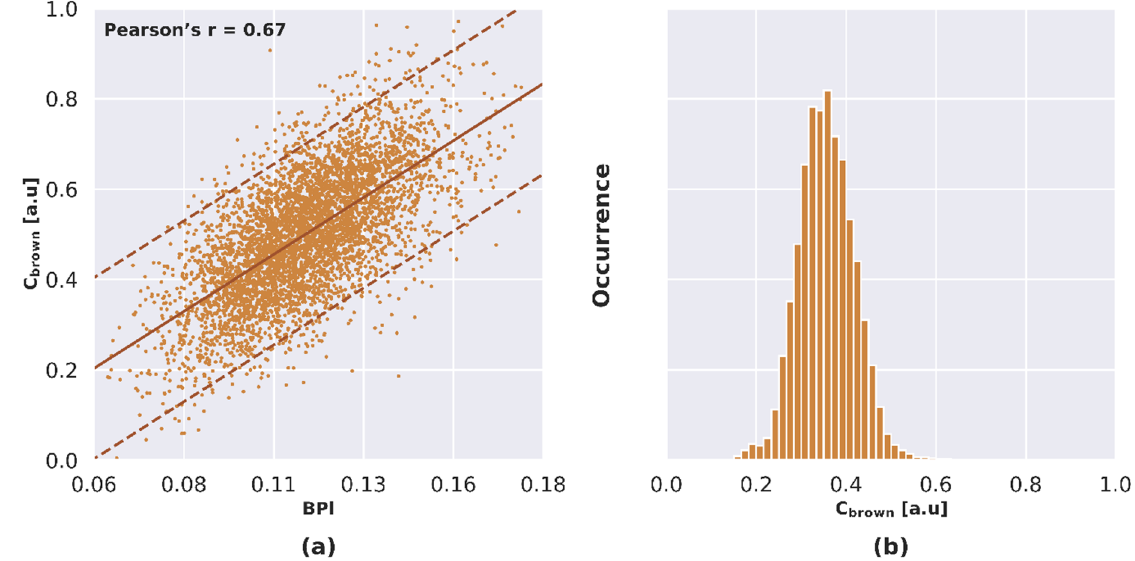
Figure 5. ( a ) Relationship between Brown Pigment Reflectance Index (BPI) and C brown obtained from DART simulation on site A: the plain line corresponds to the linear relationship, and the dashed lines correspond to the standard deviation for this relationship; ( b ) C brown computed for Site B, based on linear models relating BPI to C brown , adjusted from the NPVf Cbrown scenarios applied on Site A.